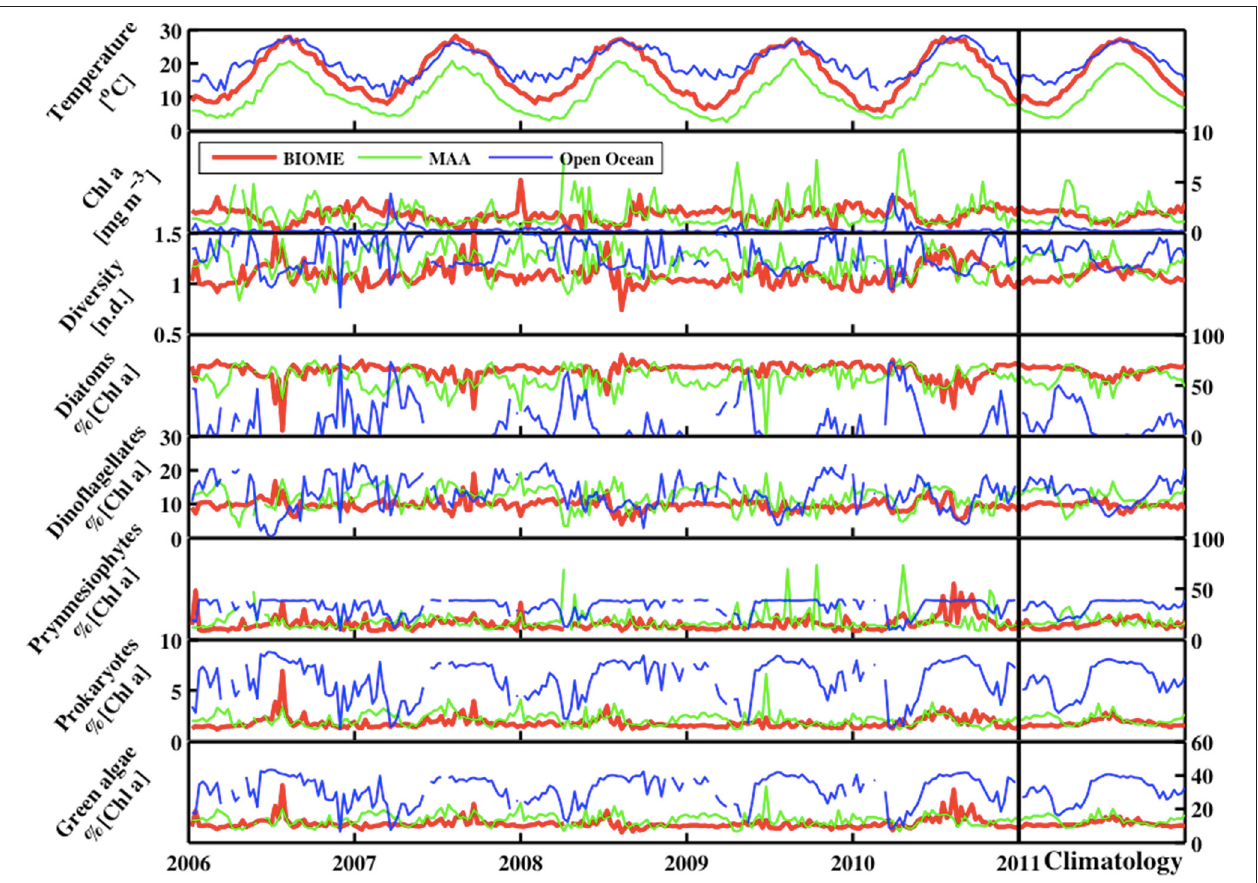
FIGURE 10 | The temporal distribution for sea surface temperature ( ◦ C), Chl SAT , Shannon Diversity Index (H; n.d.), and phytoplankton functional types (% chlorophyll a) for Diatoms, Dinoflagellates, Prymnesiophytes, Prokaryotes, and Green Algae from 2006 to 2011 for three stations including the Mid Atlantic Bight, Gulf of Maine, and open